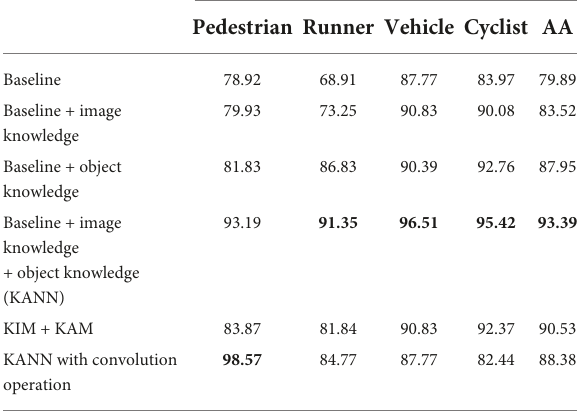
TABLE 5 Experimental results of the ablation